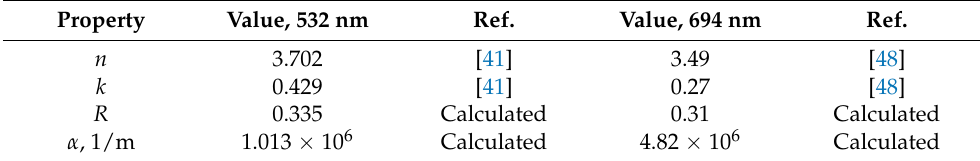
Table A18. c -InP—optical properties.